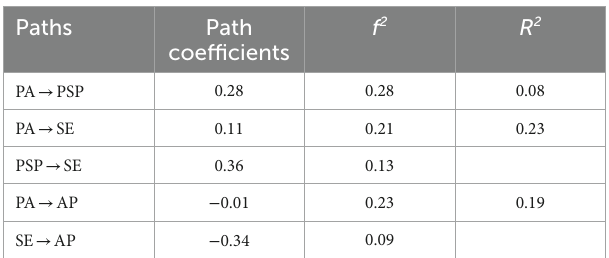
TABLE 4 R 2 and f 2